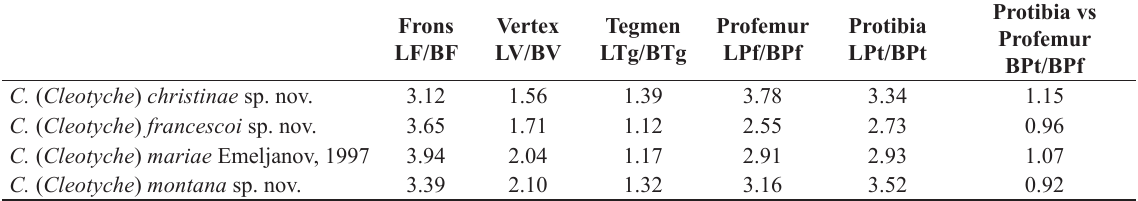
Table 1. Comparative morphometric ratios of species of Cleotyche ( Cleotyche ) Emeljanov, 1997.